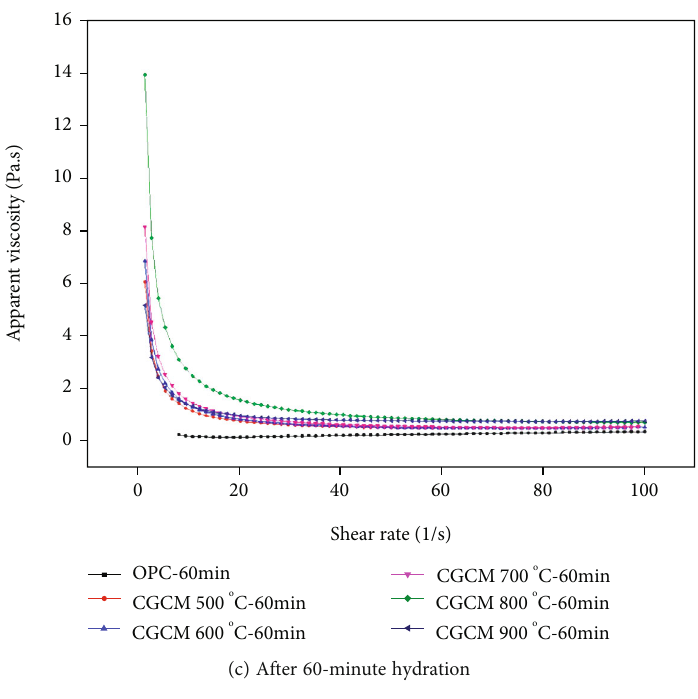
Figure 5: Time viscosity curve of fresh slurry mixed with heated-activated coal gangue. Table 2: Fitting results of the modi fi ed Bingham rheological model of CGCM slurry.